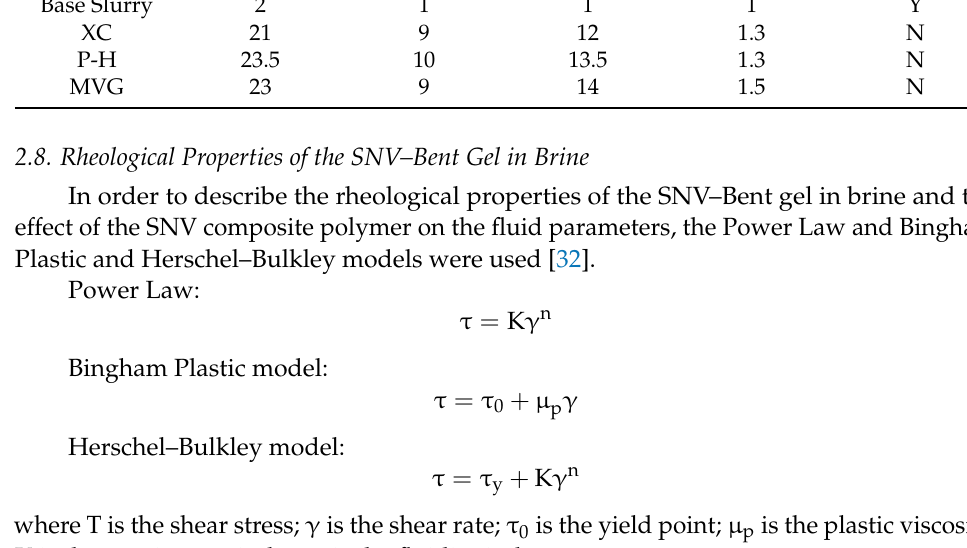
Figure 7. Rheological model of shear rate and shear strength of the SUV–Bent gel system. The τ (cid:2868) of SNV–Bent gels with different MVG/XC ratios was calculated by the Her- schel–Bulkley model, as shown in Figure 8. It can be seen that when the XC ratio was ≤ 1/5, τ (cid:2868) was 0. When the XC ratio was 1/10, the SNV–Bent gel system was prone to solid–liquid phase separation. With the increase in XC addition, τ (cid:2868) also increased, and the stability of the gel system also increased. Considering that τ (cid:2868) reflects the stability of the gel system, the results showed that the larger the value of τ (cid:2868) , the greater the gel stability. The addition